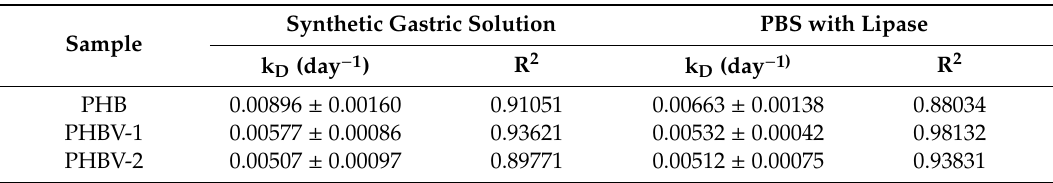
Table 7. Kinetic model parameters and coe ffi cients of determinations (R2) for the degradation of PHB, PHBV-1, and PHBV-2 in model fluids at 37 ◦